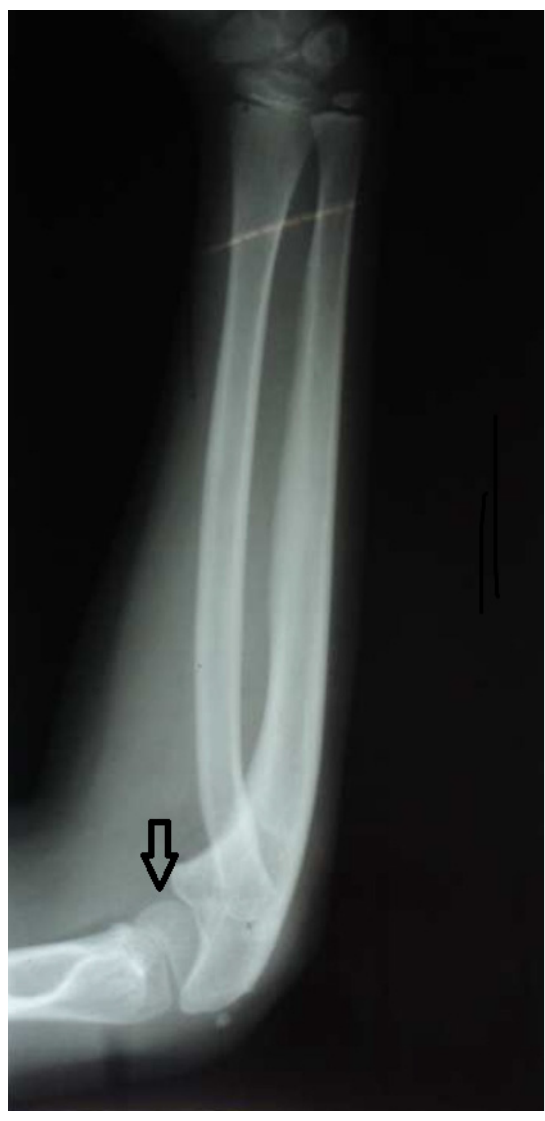
Figure 1. Pre-operative X-ray showing congenital radial head dislocation with the radius bowed anteriorly. The capitulum is